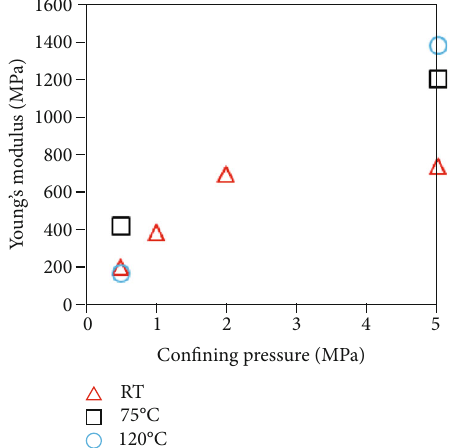
Figure 11: Characteristics of oil sand Young ’ s modulus under di ff erent con fi ning pressures and